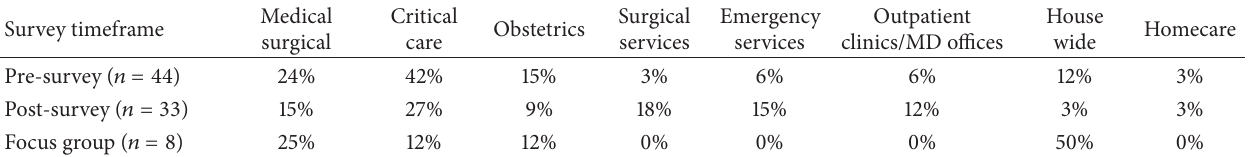
Table 3: Nursing work areas.